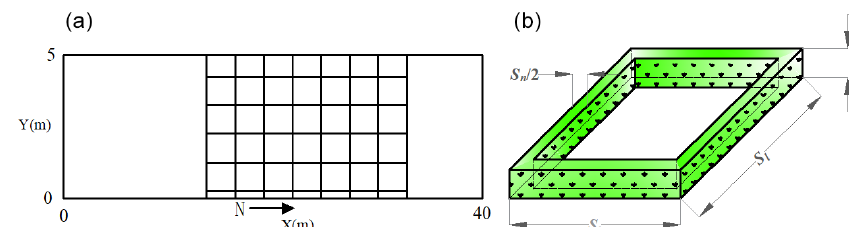
Figure 1. The diagram of the laying SCBs and a single SCB.